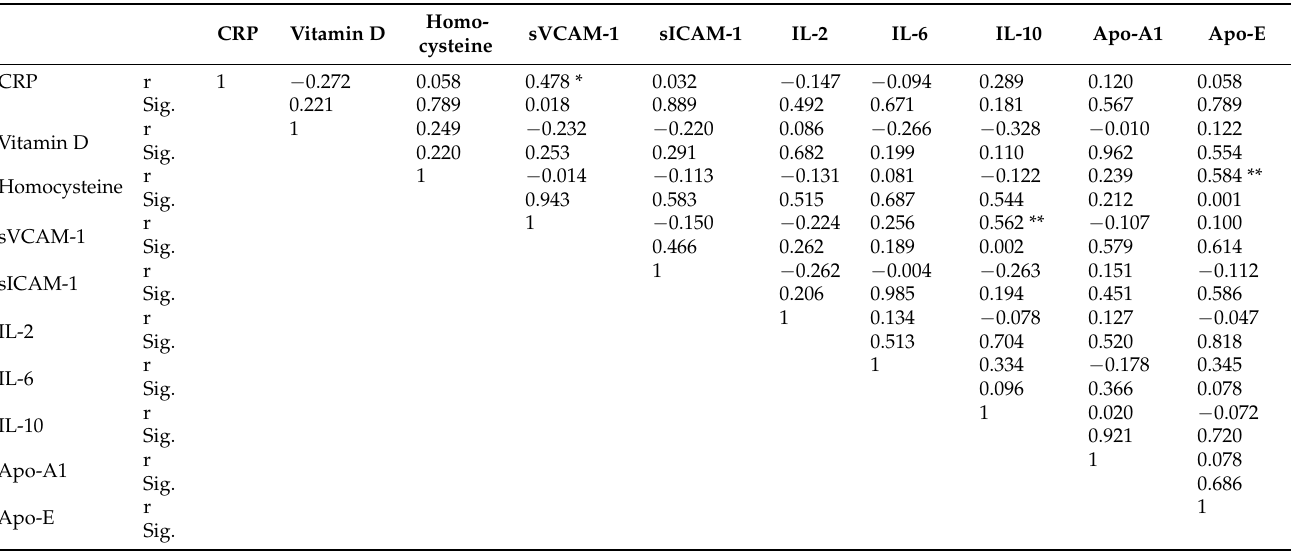
Table 3. Pearson correlation between parameters in OCAD. ** Correlation was significant at p < 0.01; * correlation was significant at p <